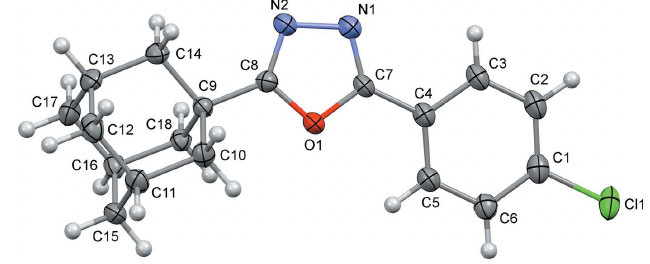
Figure 3 View of the structural overlay of compounds (I) and (II). Compound (I) is drawn according to element type, while compound (II) is drawn in pale green.